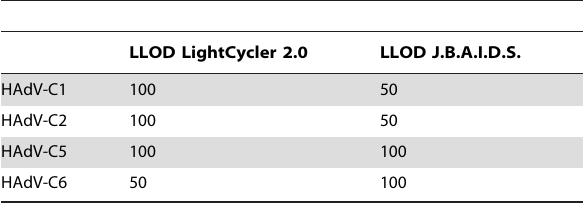
Table 2. LLOD for HAdV singleplex reactions (genome